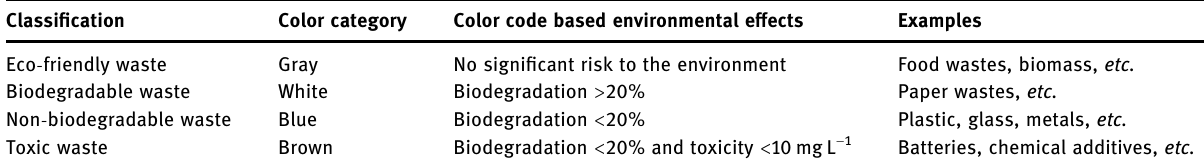
Classi fi cation Color